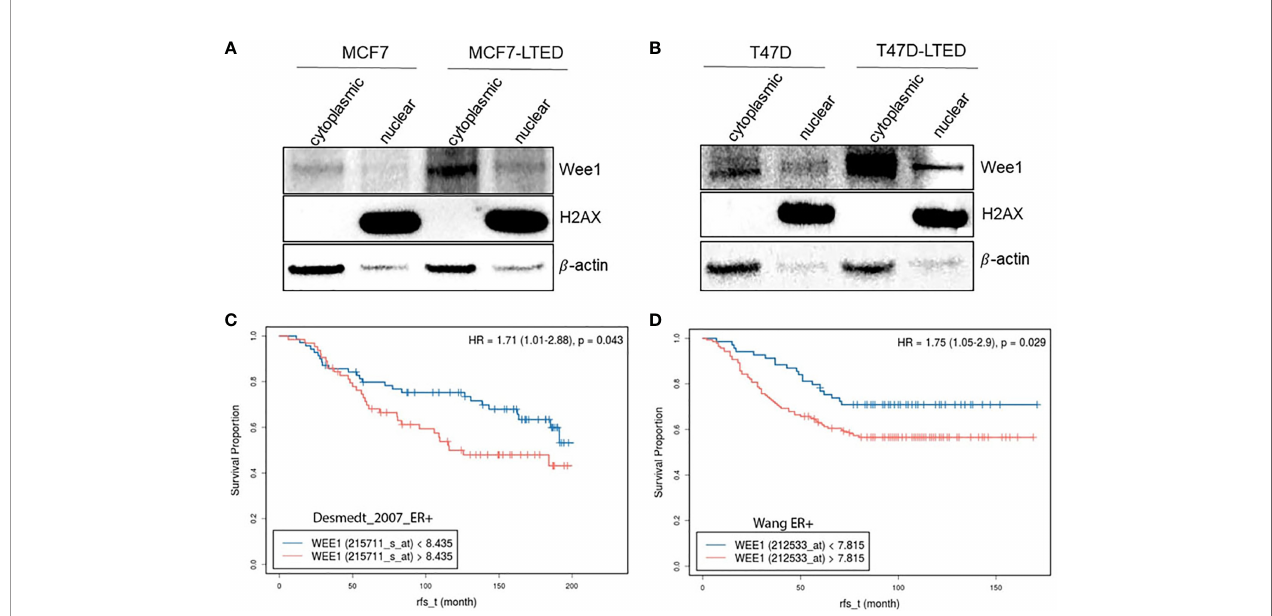
FIGURE 10 | Increased WEE1 correlates with survival of LTED cells and with poor prognosis in breast cancer. (A, B) Protein samples from MCF7 and T47D and their LTED derivatives (MCF7-LTED and T47D-LTED) were collected under basal conditions and fractionated to nuclear or cytoplasmic fractions and immunoblotted with indicated antibodies. Increased WEE1 protein levels was detected in both cytoplasm or nuclei of MCF7-LTED cells compared with the corresponding fractions in MCF7 cells. Similarly, in T47D-LTED cells, WEE1 protein levels were increased in cytoplasmic and nuclear fractions compared with the corresponding fractions in T47D cells. Total H2AX (nuclear fractions) and b -actin (cytosolic fractions) were used as controls. Blot represents one of three independent experiments. (C, D) Kaplan-Meier survival curves was generated using two databases (GSE2034; n=134, GSE7390; n=209). Higher WEE1 gene expression (red) correlated with reduced relapse free survival (rfs) compared with low WEE1 gene expression